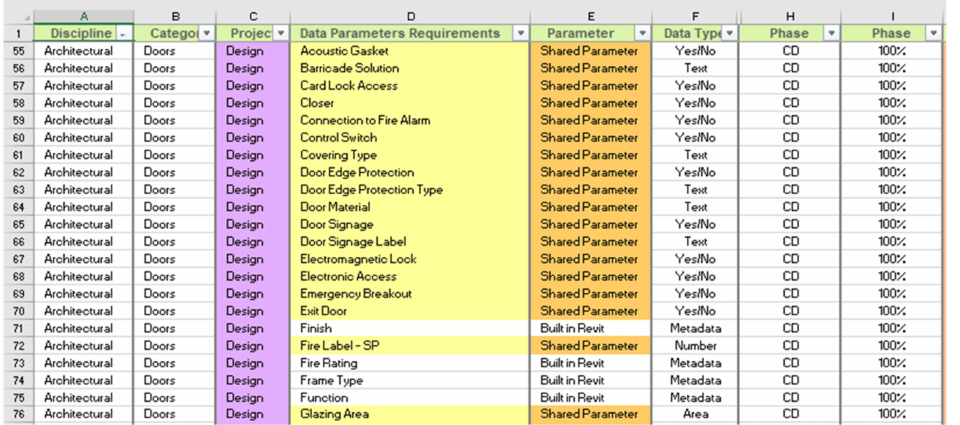
Figure 8. Screenshot of DGS with examples of data parameters required for the Revit category